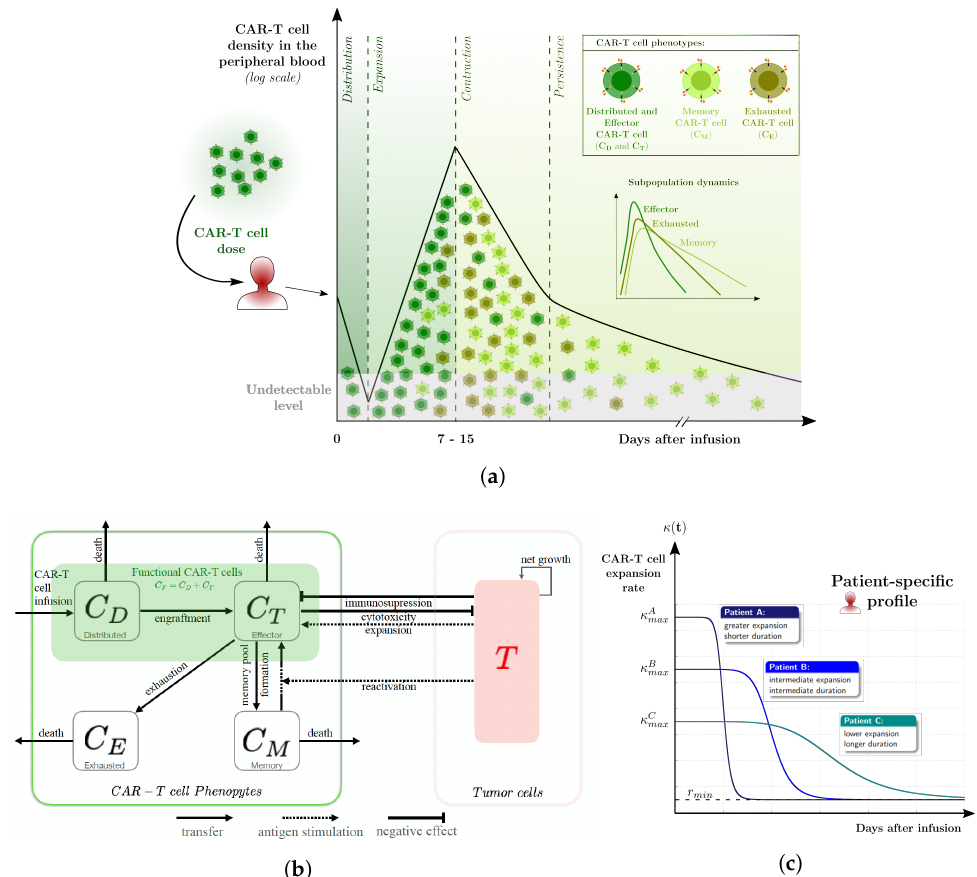
Figure 1. Multiphasic CAR-T cell dynamics. ( a ) Schematic representation of the multiphasic response to CAR-T cell therapy as described by the model. After CAR-T infusion, the typical response profile shows a rapid and usually undetectable decline of circulating CAR-T cells, featuring the distribution phase. The expansion phase is characterized by the antigen-mediated proliferation of engrafted CAR-T cells and reaches its peak about two weeks after starting treatment. Over time, effector cells contribute to the formation of the memory cells but also lose proliferative and cytotoxic capacities, becoming exhausted CAR-T cells. The expansion peak is followed by a contraction phase, marked by a sharp decay of CAR-T cells. The longer lifespan of memory cells leads to a long period of smooth decline, which characterizes the persistence phase. ( b ) Schematic description of the CAR-T immunotherapy model in patients. The CAR-T cells infused into the patient undergo a rapid distribution phase ( C D ). Part of these cells undergoes engraftment and settles in the blood and tumor niche. Engrafted cells are called effector CAR-T cells ( C T ) and expand upon antigen contact, differentiate into memory CAR-T cells ( C M ), become exhausted ( C E ), and die naturally or are targeted by tumor immunosuppressive mechanisms. Both C T and C D populations present cytotoxic effects and, therefore, are named functional CAR-T cells. Memory CAR-T cells die naturally but are readily responsive to antigen-positive cells. When they interact with tumor cells, they differentiate back into effector CAR-T cells, producing a rapid immune response against the tumor. Over time, effector CAR-T cells become exhausted and are eliminated. Tumor cells ( T ), which express the specific target antigen, grow depending on the resources available in the microenvironment and are killed by functional CAR-T cells. The net growth of tumor cells results from the balance between their proliferation and natural death. ( c ) Illustrative patient profiles of the function κ ( t ) , describing the antigen-mediated and time-dependent expansion rate of engrafted CAR-T cells. Individual characteristics and heterogeneity of the infused product ultimately define the strength and duration of each phase of the CAR-T cell